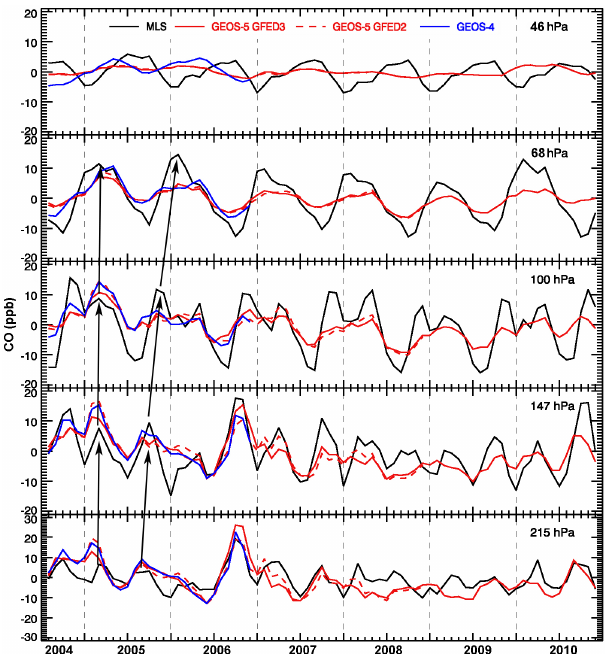
Fig. 11. Temporal variation of monthly mean MLS CO and model CO deviations zonally-averaged over the tropics (10 ◦ S–10 ◦ N) at 215hPa, 147hPa, 100hPa, 68hPa and 46hPa. Black lines show MLS observations. Red solid lines show model results from GEOS- 5 with GFED3 emissions and red dashed lines show those with GFED2 emissions. Blue lines show model results from GEOS-4. Arrows illustrate the vertical transport of the CO maximum from Southern Hemisphere biomass burning and from Northern Hemi- sphere biomass